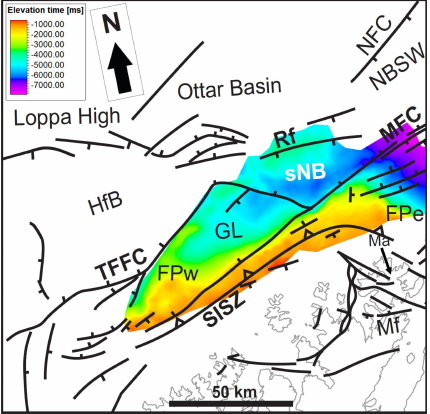
Figure 7. Time surface map of the top reflection of the SISZ and major brittle faults in the SW Barents Sea. Note the spoon-shaped depression formed by the SISZ on the western Finnmark Plat- form and southwesternmost Nordkapp basin, the abrupt change to a northeastward dip on the eastern Finnmark Platform, and the two narrow, NE–SW- and ENE–WSW-trending ridges in the footwall of the TFFC and of the Rolvsøya